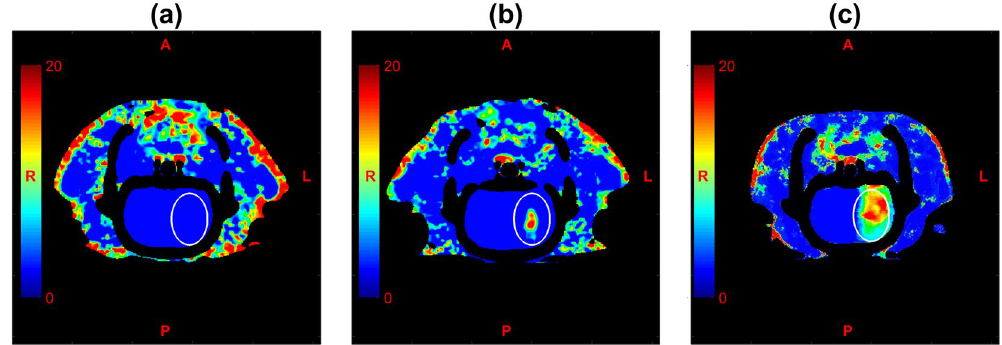
Figure 2. Maps of the permeability surface-area product (PS) generated by CT perfusion software: ( a ) prior to sonication, ( b ) after sonication, FUS POWER = 1 W, same animal as in ( a ), and ( c ) after sonication FUS POWER = 2 W, different animal. The oval represents the ROI used in CT data analysis (see Methods).